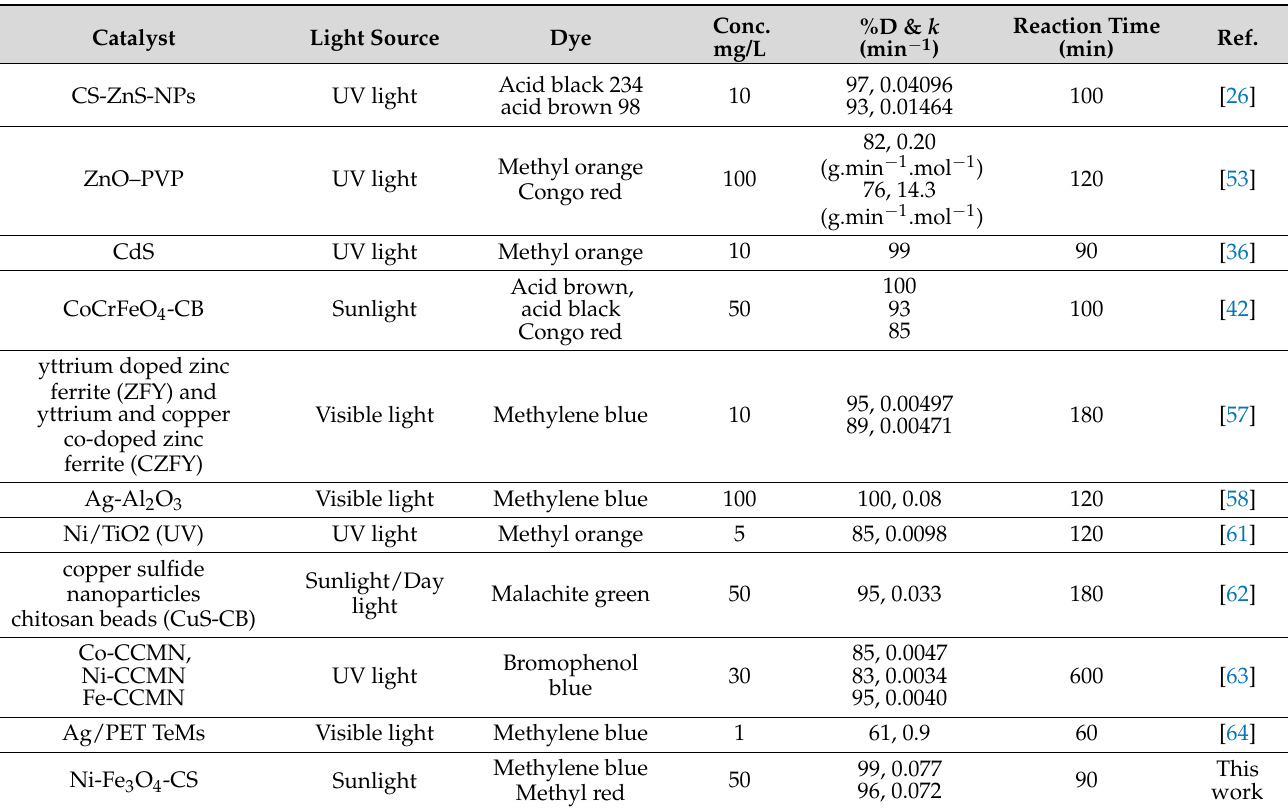
Table 4. Comparison of the various bio-composite based photocatalysts for the photocatalytic degradation of azo